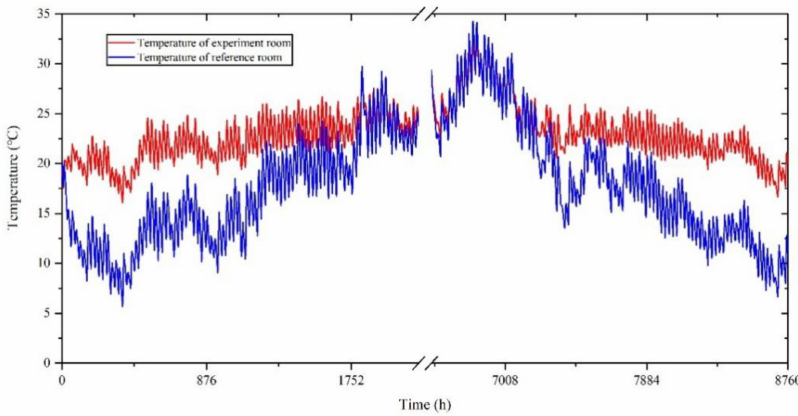
Figure 14. Indoor temperature comparison between experimental room and reference